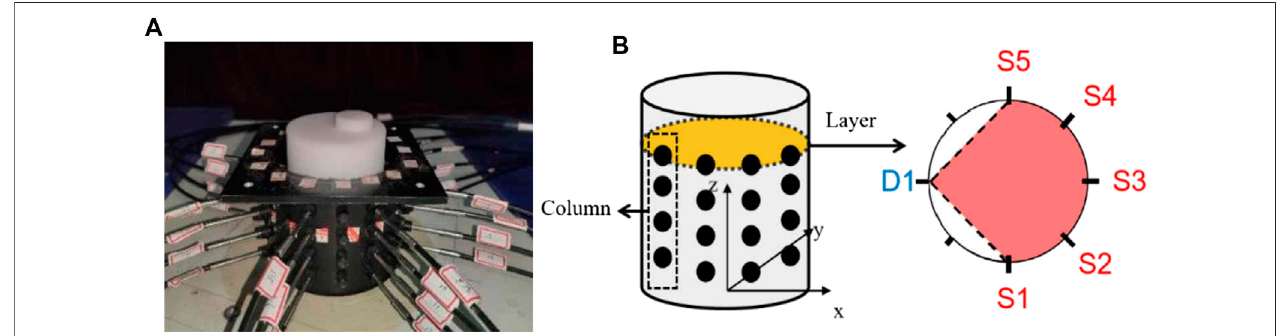
FIGURE 3 | Picture of the optical fi ber distribution around imaging chamber and the sketch